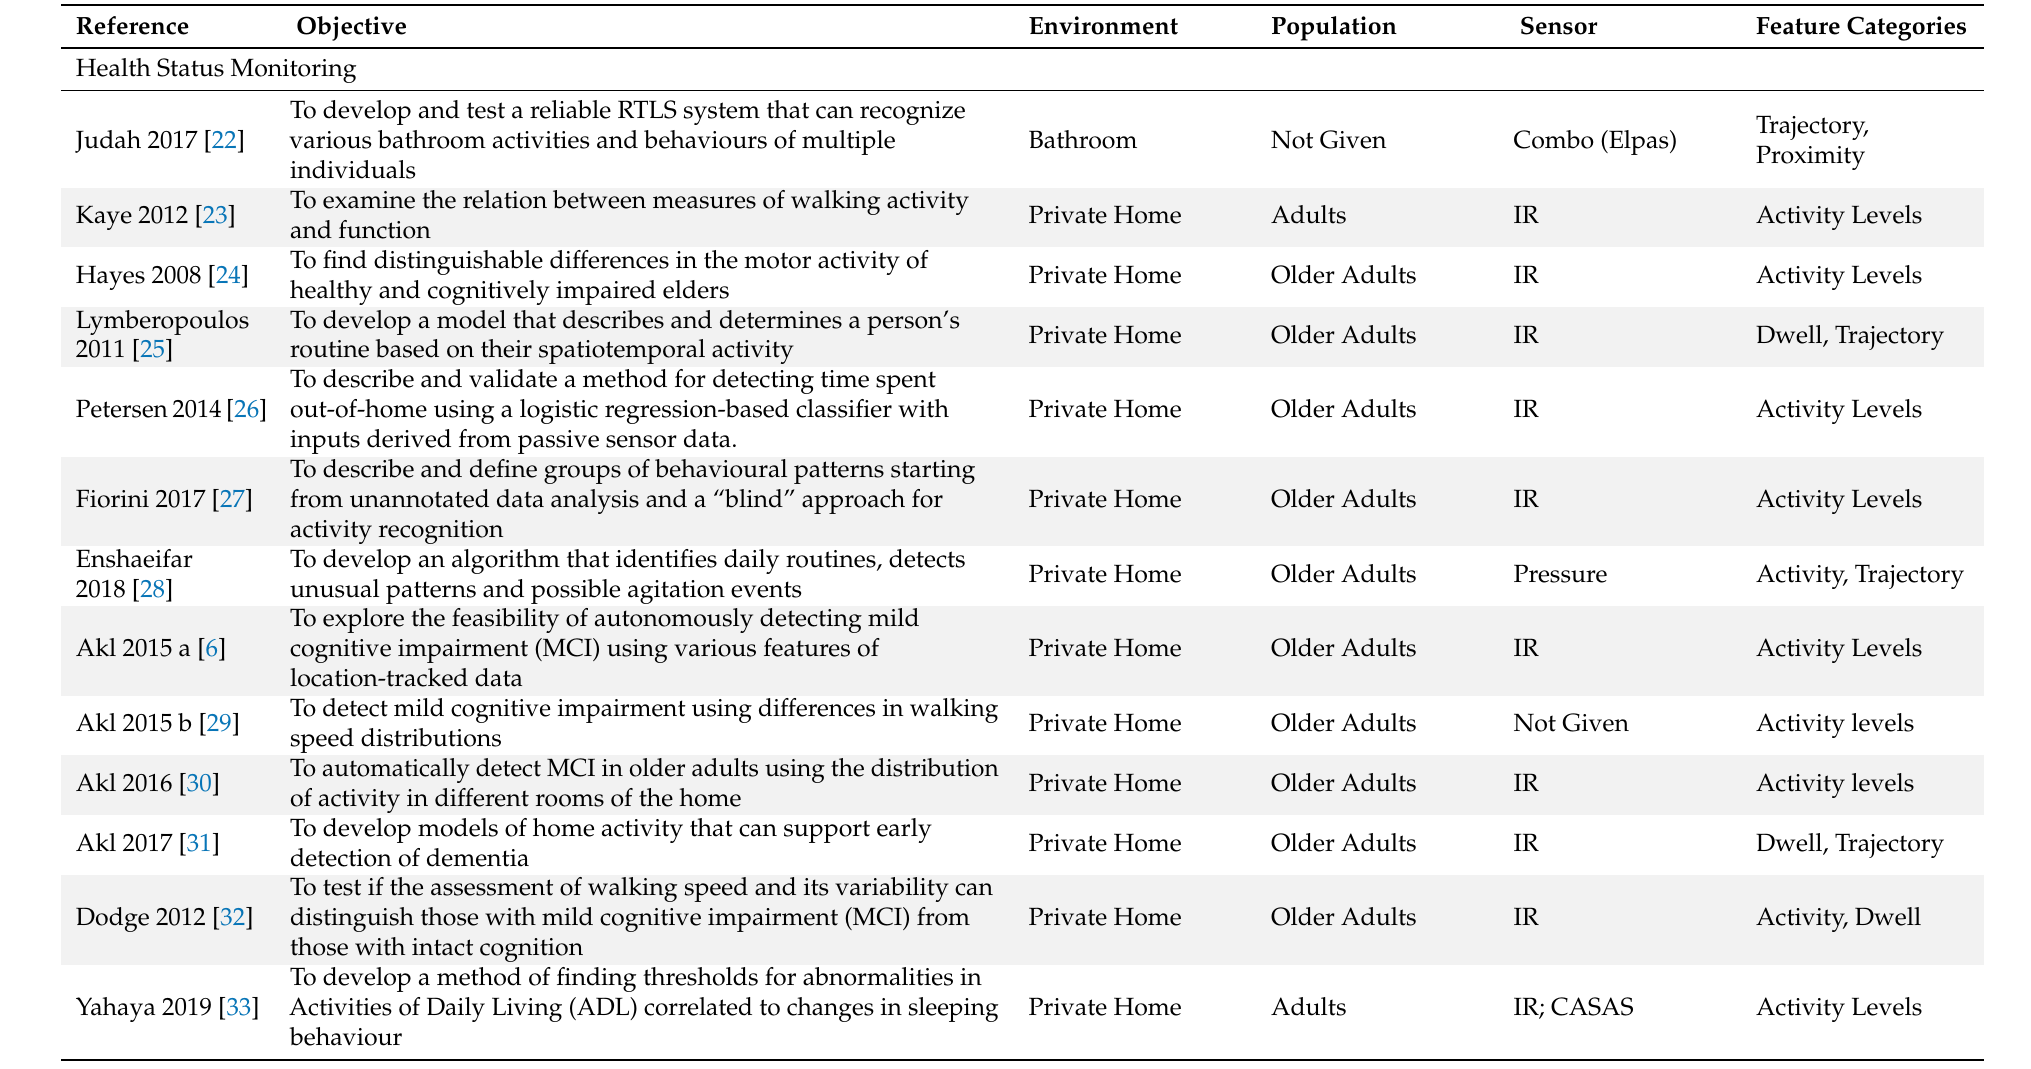
Table 2. Details of the 79 studies included in scoping review